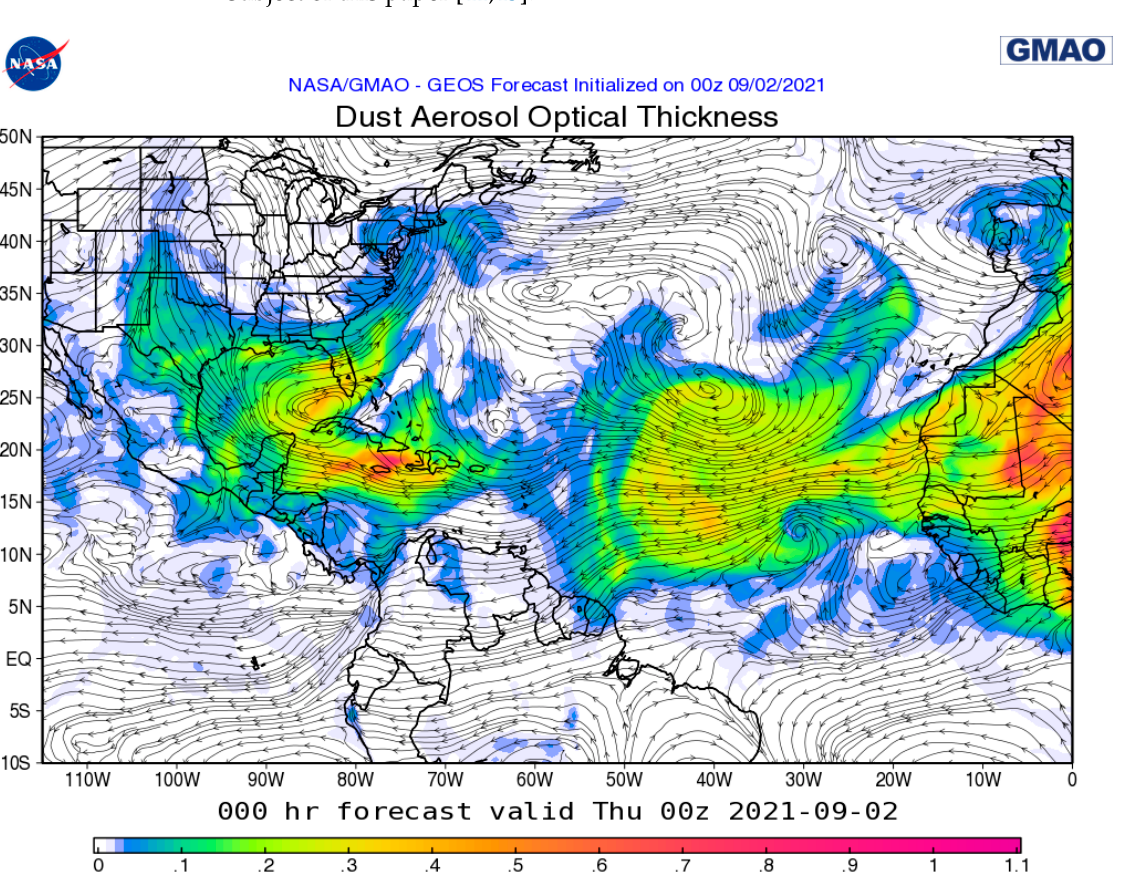
Figure 1. Optical thickness of African dust across the Atlantic Ocean southeastern United States, Including Florida [26].